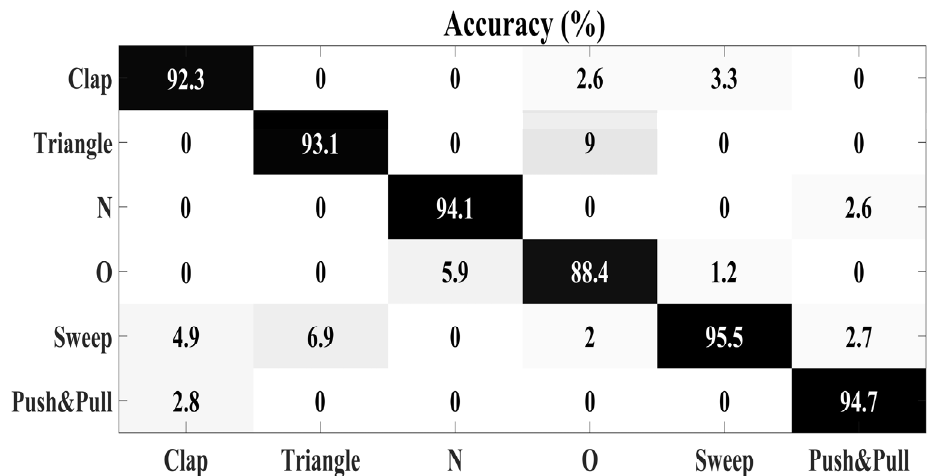
Figure 11. Recognition accuracy of each gesture.